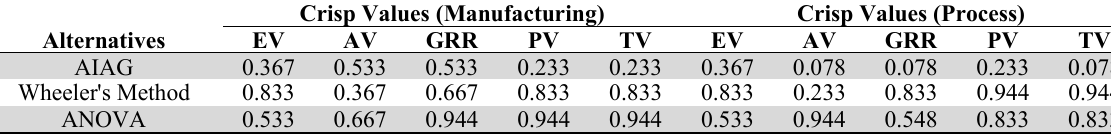
Crisp Value for Manufacturing & Process Industries